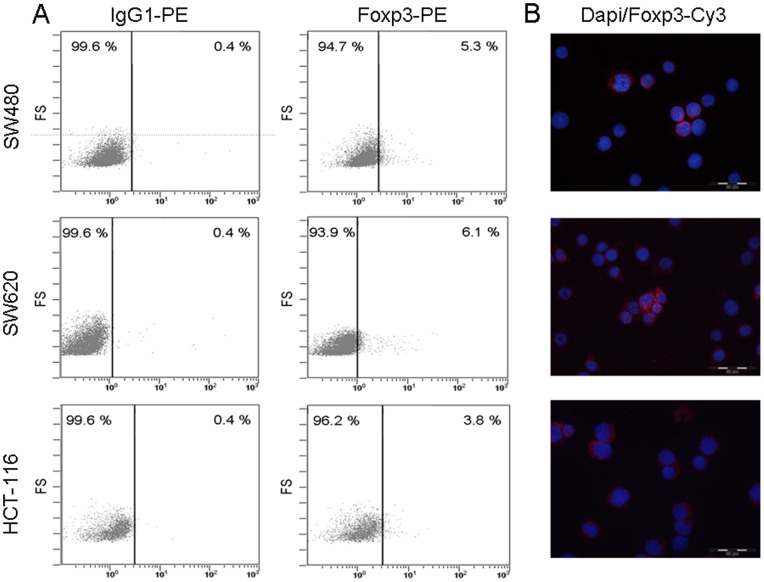
Protein expression of Foxp3 in colon cancer cell lines by flow cytometry and immunofluorecence double staining analysis.(A) Flow cytometry assay of Foxp3 expression in SW480, SW620, and HCT-116 colon cancer cell lines compared to isotype control. 3.8% to 6.1% of colon cancer cells express Foxp3; PE: phycoerythrin; FS: forward scatter linear. (B) Representative examples of immunofluorescence double staining of Foxp3+ expression in SW480, SW620, and HCT-116 cancer cells. Cy3, indocarbocyanin red and DAPI 4′,6-Diamidino-2- phenylindoldihydrochlorid blue – nuclear counterstaining (×400 magnification).